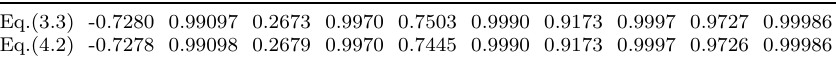
Table 1. Optimal sets of iteration parameters for J=200, and